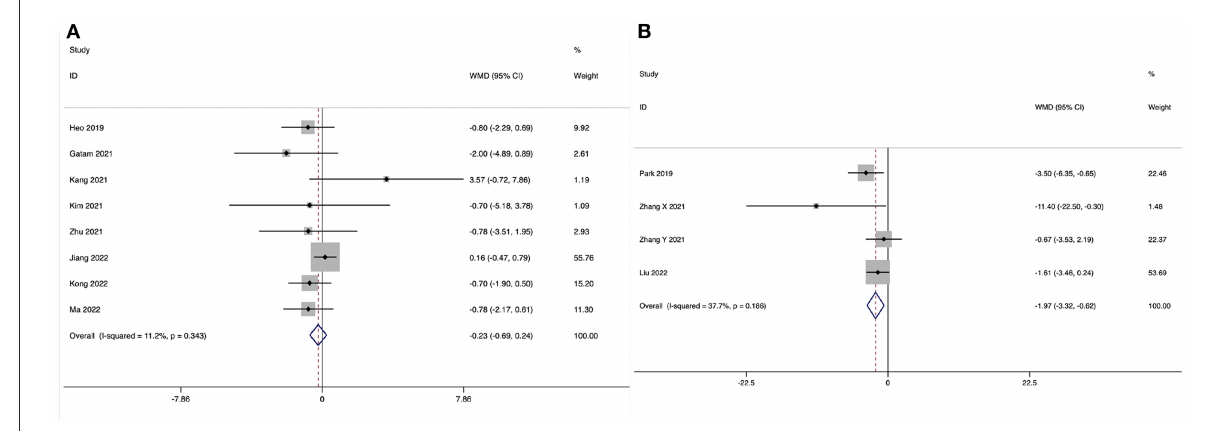
FIGURE6 Forest plot of the Oswestry Disability Index at the final follow-up. (A) ULIF vs. MI-TLIF; (B) ULIF vs. PLIF.